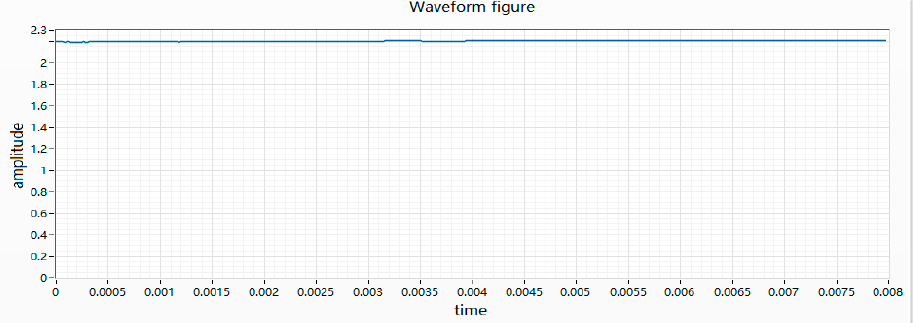
Figure 4. Waveform of a motor armature sticking.